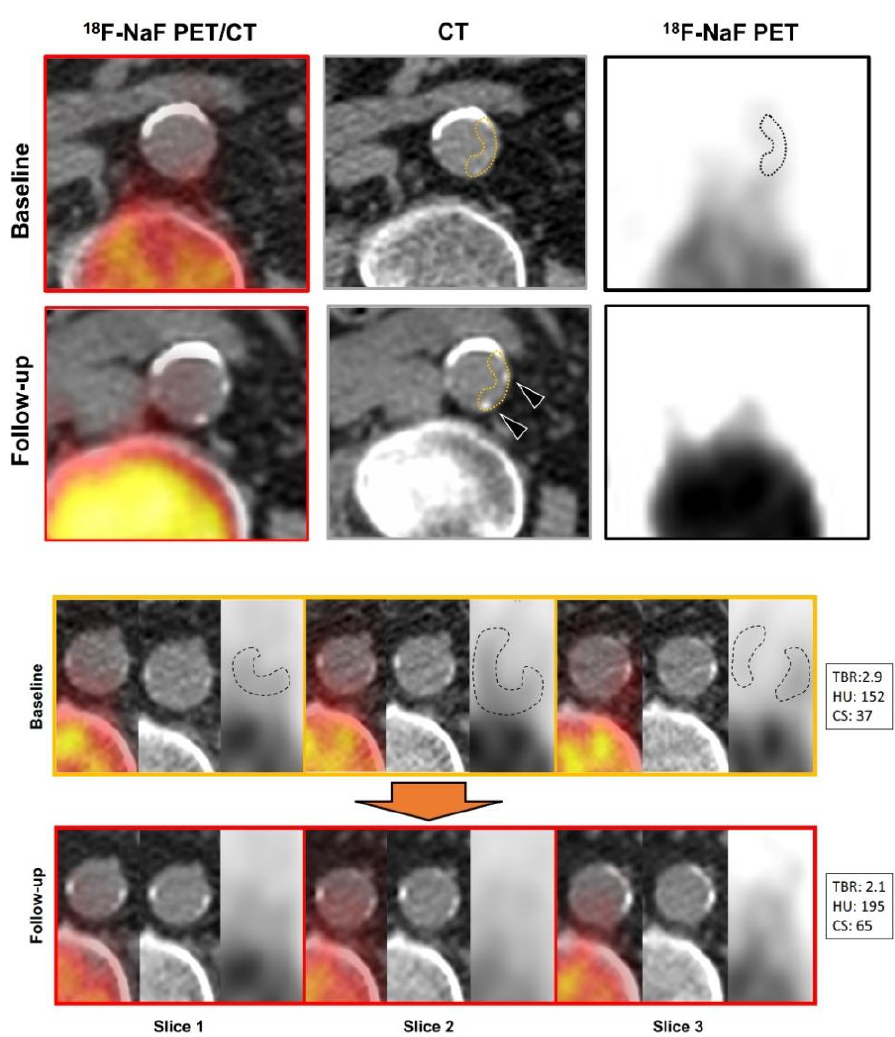
Figure 2. Appearance of Calcifications in Areas of Increased NaF Uptake and Evolution of “Hot” Plaques. Top panel: Fused and PET images show increased NaF uptake in the posterior and left lateral aortic wall (top row, left and right images, dashed outlines). At follow-up, two point-shaped calcifications have appeared (bottom row, left and center images, see arrowheads). Bottom panel: The upper series (orange box) shows three consecutive NaF-PET/CT and CT slices with mildly calcified plaques with co-localized increase in tracer uptake (dashed outlines). Follow-up images of the same slices (red box) show an increase in the lesions’ density and size, the extent of which is reflected by the increase in average HU and calcium score. TBR values were average SUV values normalized for inferior vena cava blood pool activity. Spill-over from nearby vertebrae were sought corrected for by means of brush tool editing observing a safety distance of 1 cm. Reprinted with permission from Fiz et al. [33], 2021, Springer Nature.